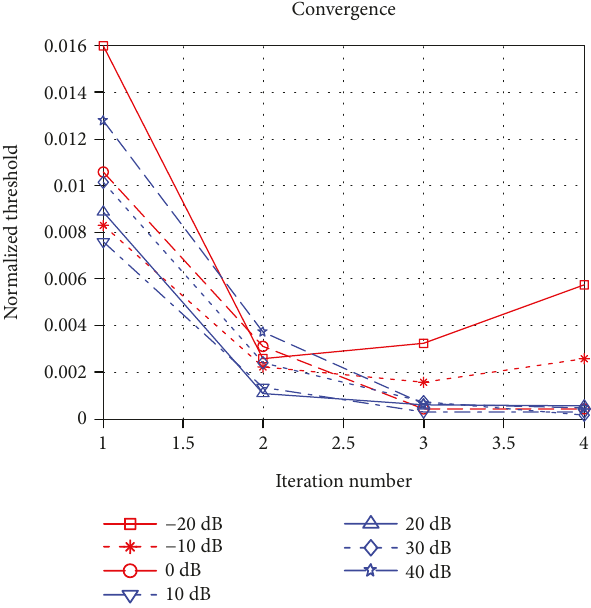
Figure 7: Convergence curve of the normalized threshold.